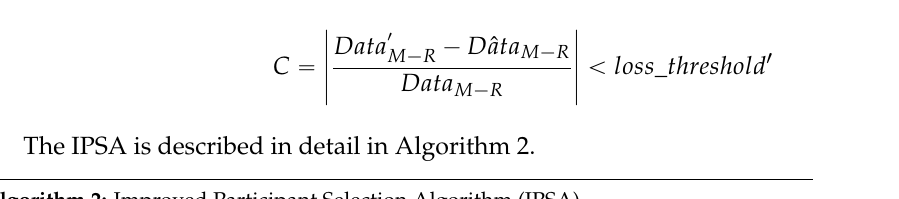
Algorithm 2: Improved Participant Selection Algorithm